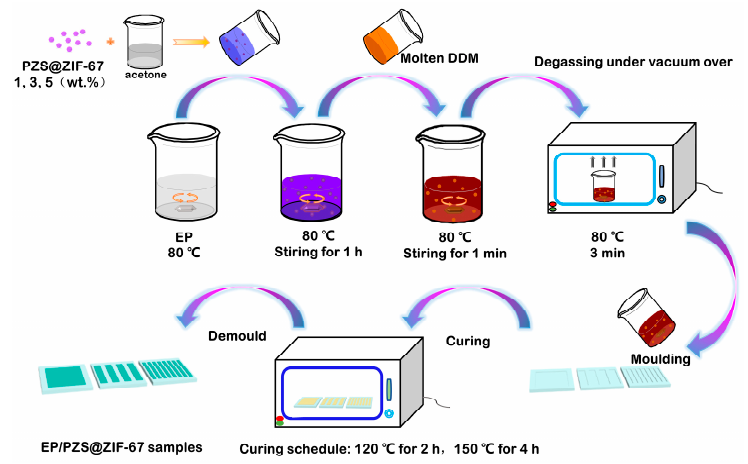
Figure 2. Schematic of the preparation of the EP/PZS@ZIF-67 composite.